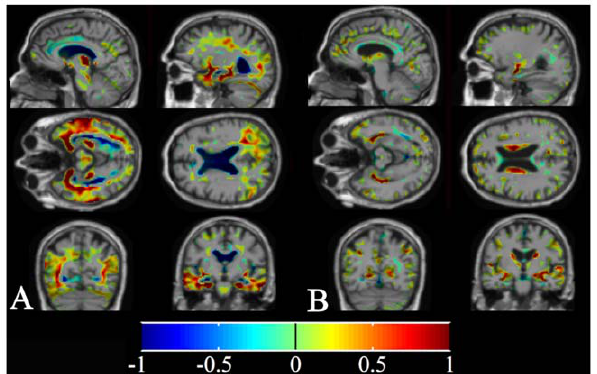
Figure 1. Weight images. Voxels with negative t-values are shown in blue colours and positive values with red colours. The actual weights used are absolute values of the values presented in this visualization. Locations with non-zero weights are shown. a . Weights used to compute the TBM features. b . Weights used to compute the VBM